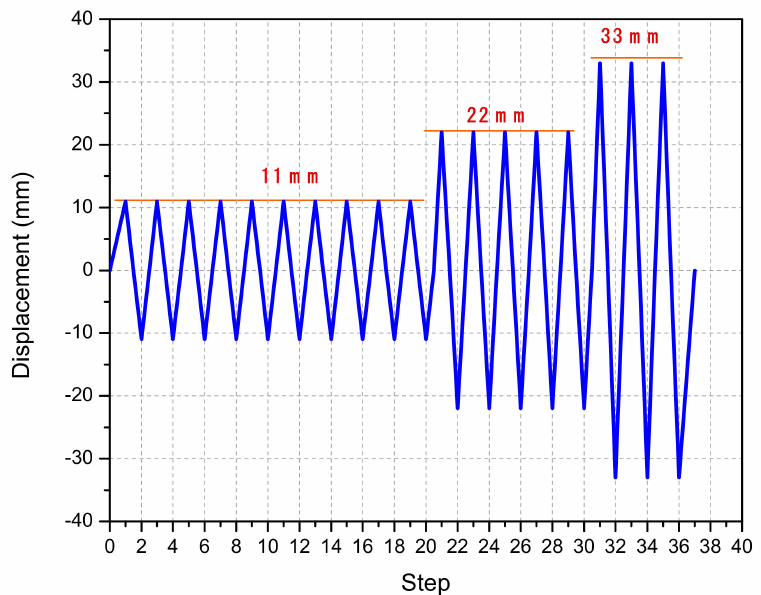
Figure 5. Cyclic loading plan.